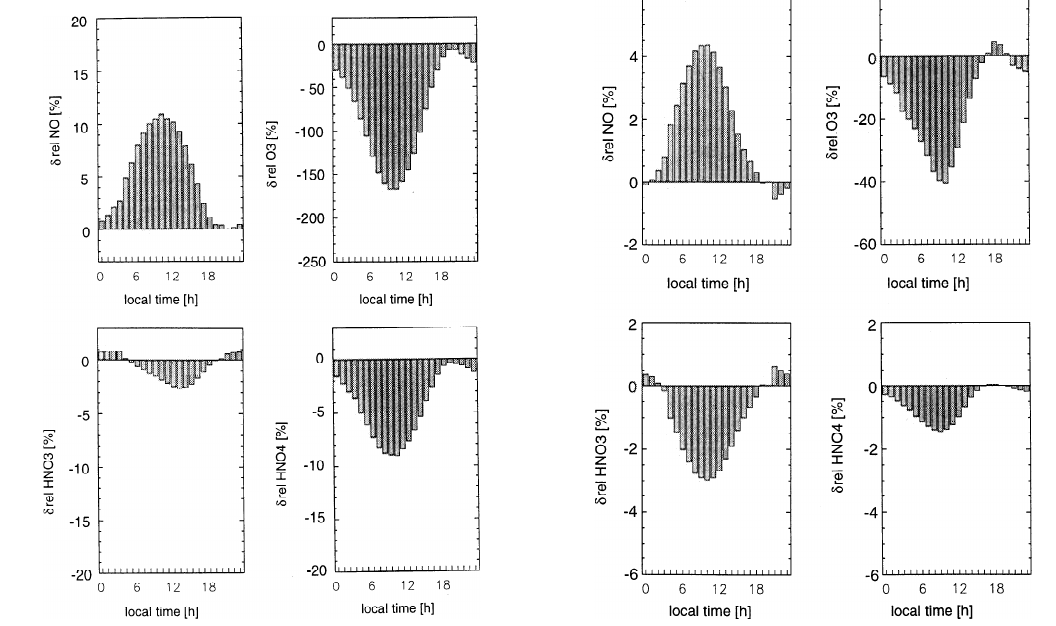
Fig. 10. Relative emission changes for calculating the effective emission indices of some key species into an unpolluted (left) and polluted (right) environment with plume lifetime is τ = 18h (Petry et al., 1998). Reprinted from Petry et al. (1998). An edited version of this paper was published by AGU. Copyright (1998) American Geophysical